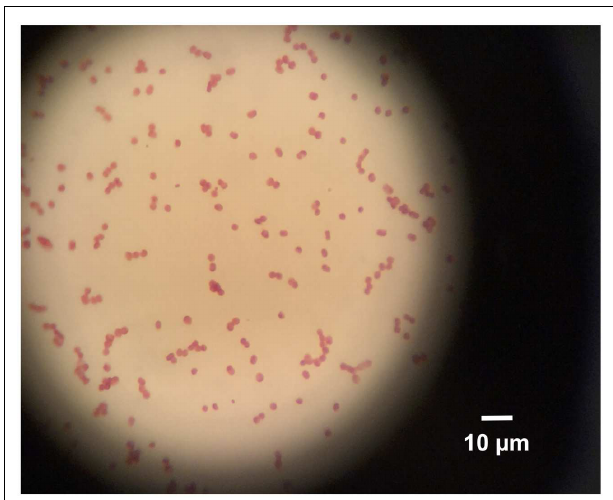
FIGURE 3 | Gram Stain, 1000 × magnification using a light microscope. Cell shape is short rods, arranged singly or in pairs.